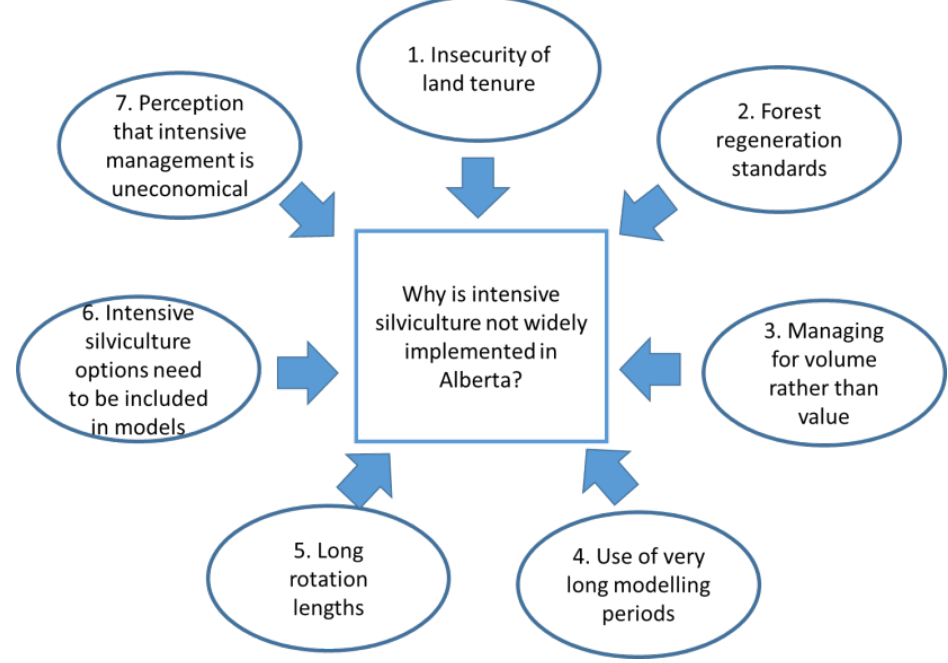
Figure 2. Factors that need updating to allow and/or promote intensive silviculture in Alberta.